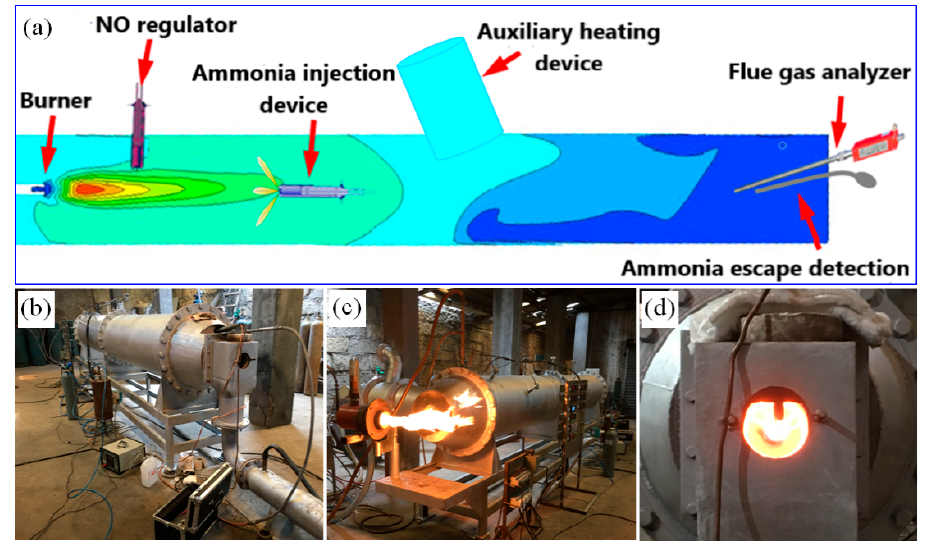
Figure 1. Schematic of the experimental system ( a ) and the laboratory-scale gas kiln ( b – d ).